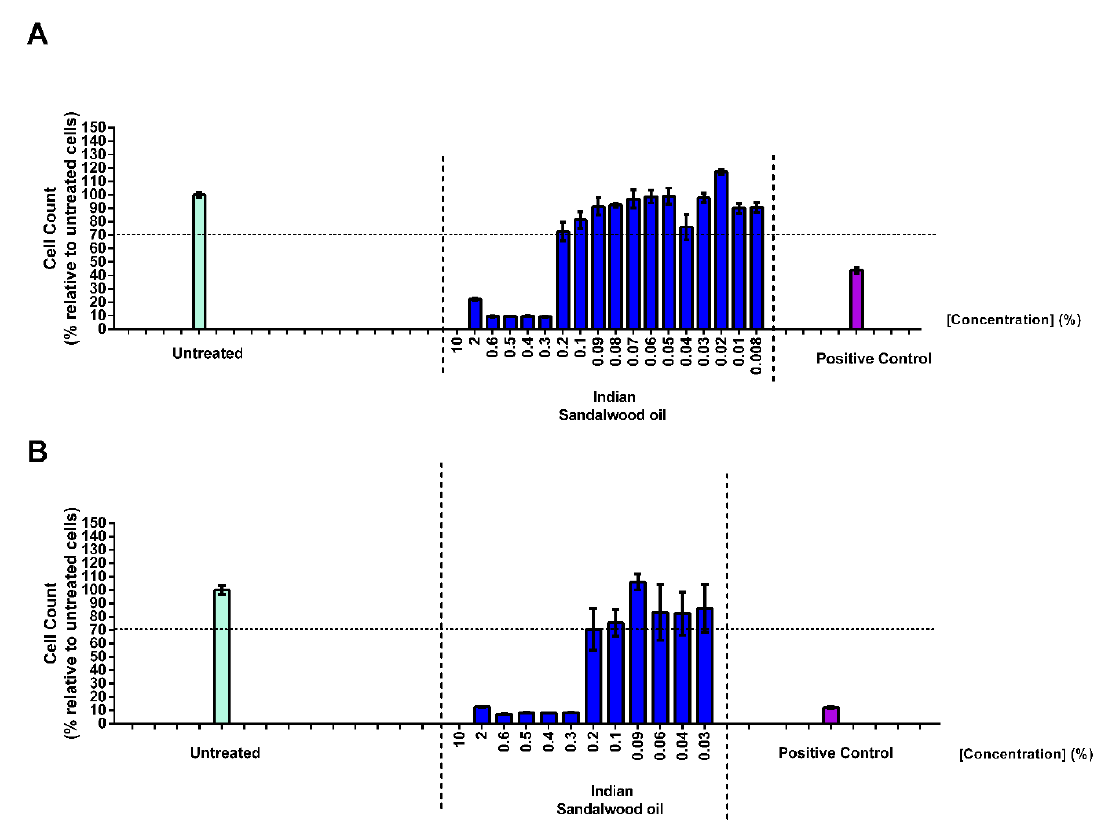
Figure 2. Assessment of the cytotoxic or anti-proliferative effect of Indian sandalwood oil on HaCaT cells after 24 h ( A ) or 48 h ( B ) of treatment. The untreated HaCaT cells are denoted in green and the treated HaCaT cells with sandalwood oil are shown in blue, while the positive control (DMSO 10%) is showed in purple. The results represent the mean value of three independent runs performed, and for each run, the samples were tested in triplicates.